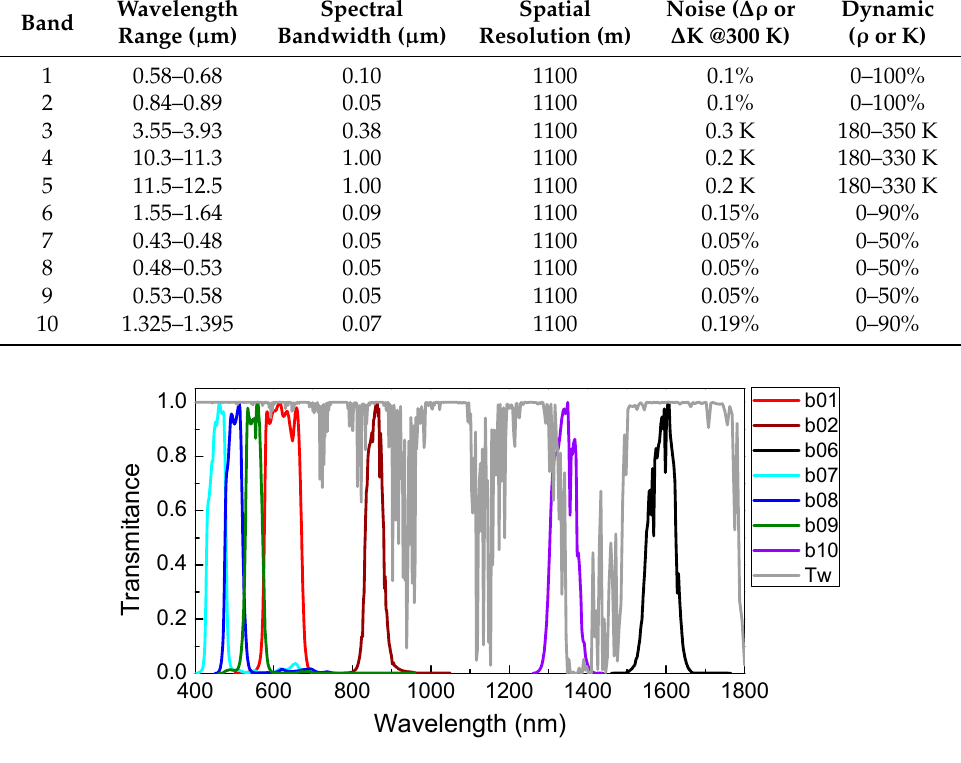
Figure 2. SRFs of FY-3A MERSI RSBs. The gray line represents the water vapor absorption transmittance simulated by using MODTRAN.